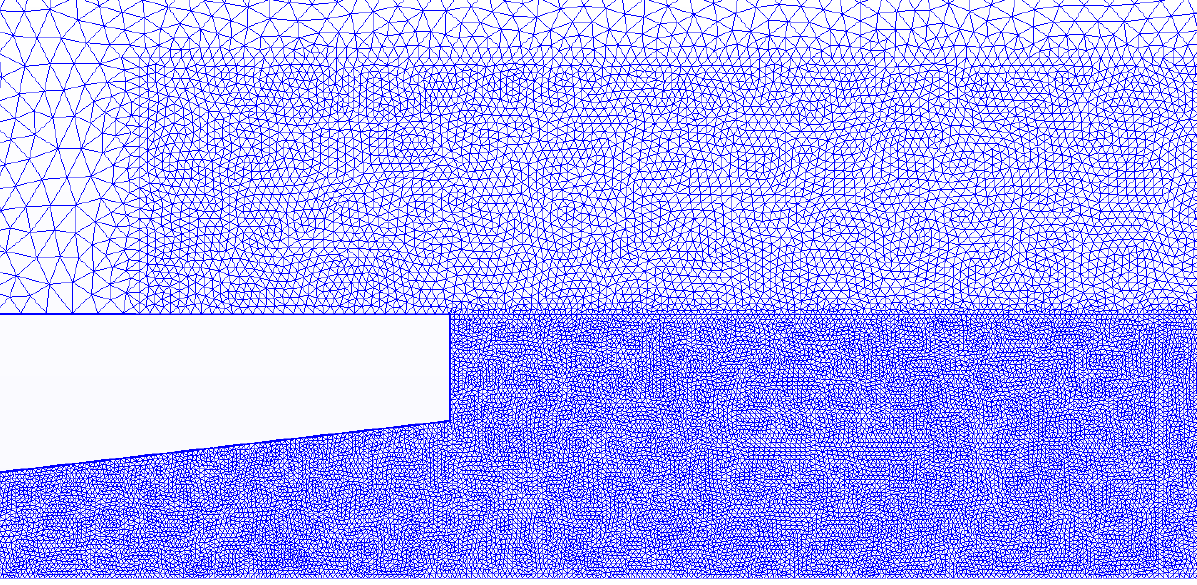
Figure 4. Mesh study. Average cavitation vapor volume fraction at the nozzle exit. The cavitation model in Autodesk CFD is introduced as the presence of constant- radius vapor bubbles; these bubbles are formed from non-condensable gas particles present in the fluid. Therefore, cavitation flow contains three components: non- condensable gas (denoted by the subscript “g”), a liquid phase (denoted by the subscript “l”) and a vapor phase (denoted by the subscript “v”). It was assumed that the mass